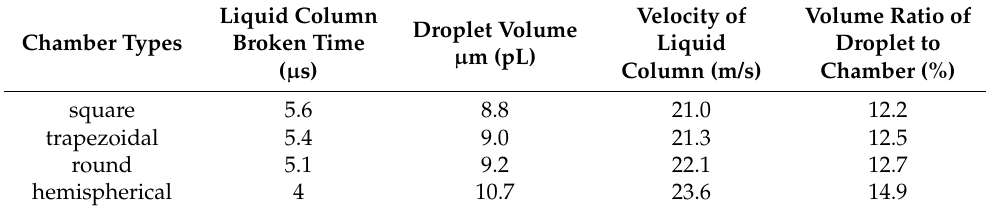
Table 2. Comparison of inkjet heads with different chambers.